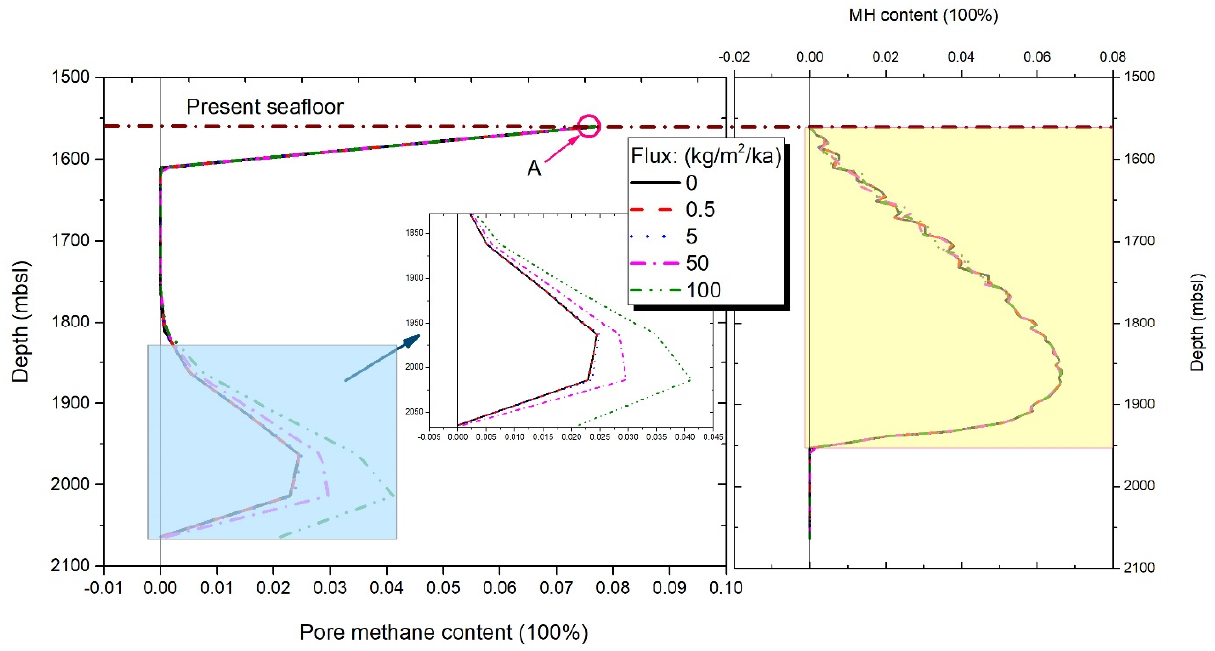
Figure 17. Vertical distribution of the gas and MH content caused by five different thermogenic gas